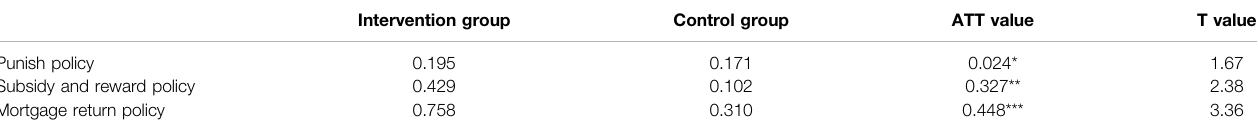
TABLE 8 | Average intervention effect of three policies calculated based on the one-to-one nearest-neighbor matching